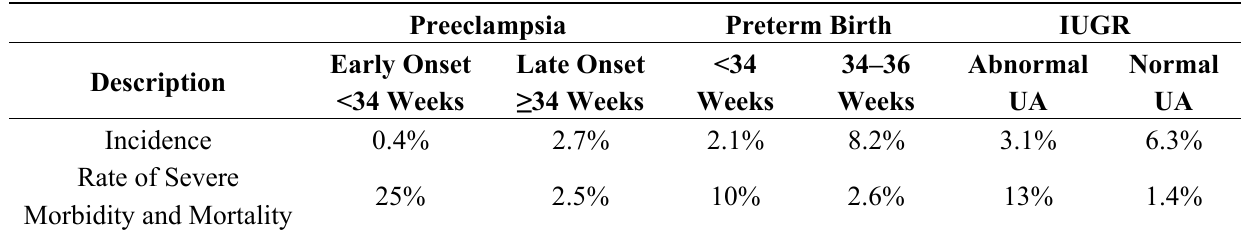
Table 4. Inverse relationship between incidence of the subcategory of adverse outcome and rate of severe morbidity and mortality associated with the subcategory. Preeclampsia Preterm Birth IUGR Early Onset Late Onset <34 34–36 Abnormal Normal Description <34 Weeks ≥ 34 Weeks Weeks Weeks UA UA Incidence 0.4% 2.7% 2.1% 8.2% 3.1% 6.3% 25% 2.5% 13%